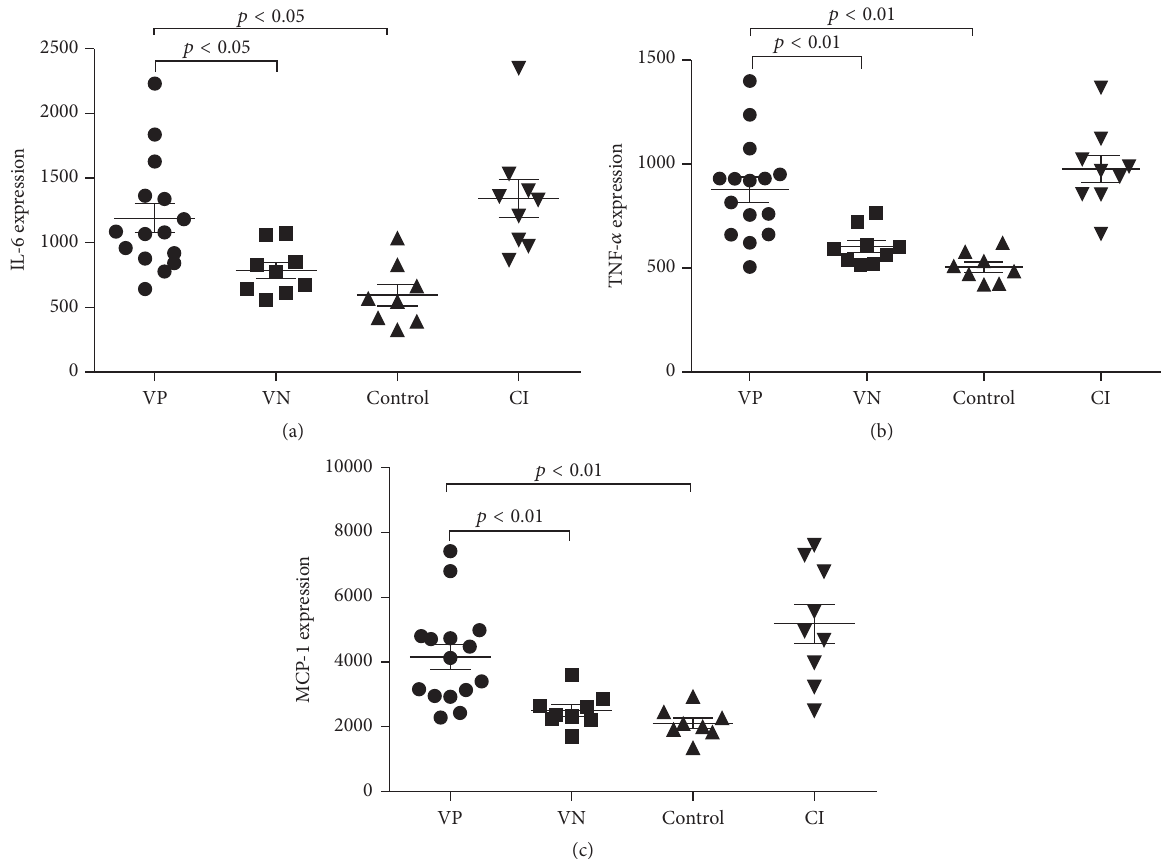
Figure 3: (a) The overexpression of IL-6 between different groups. (b). The overexpression of TNF- 𝛼 between different groups. (c). The overexpression of MCP-1 between different